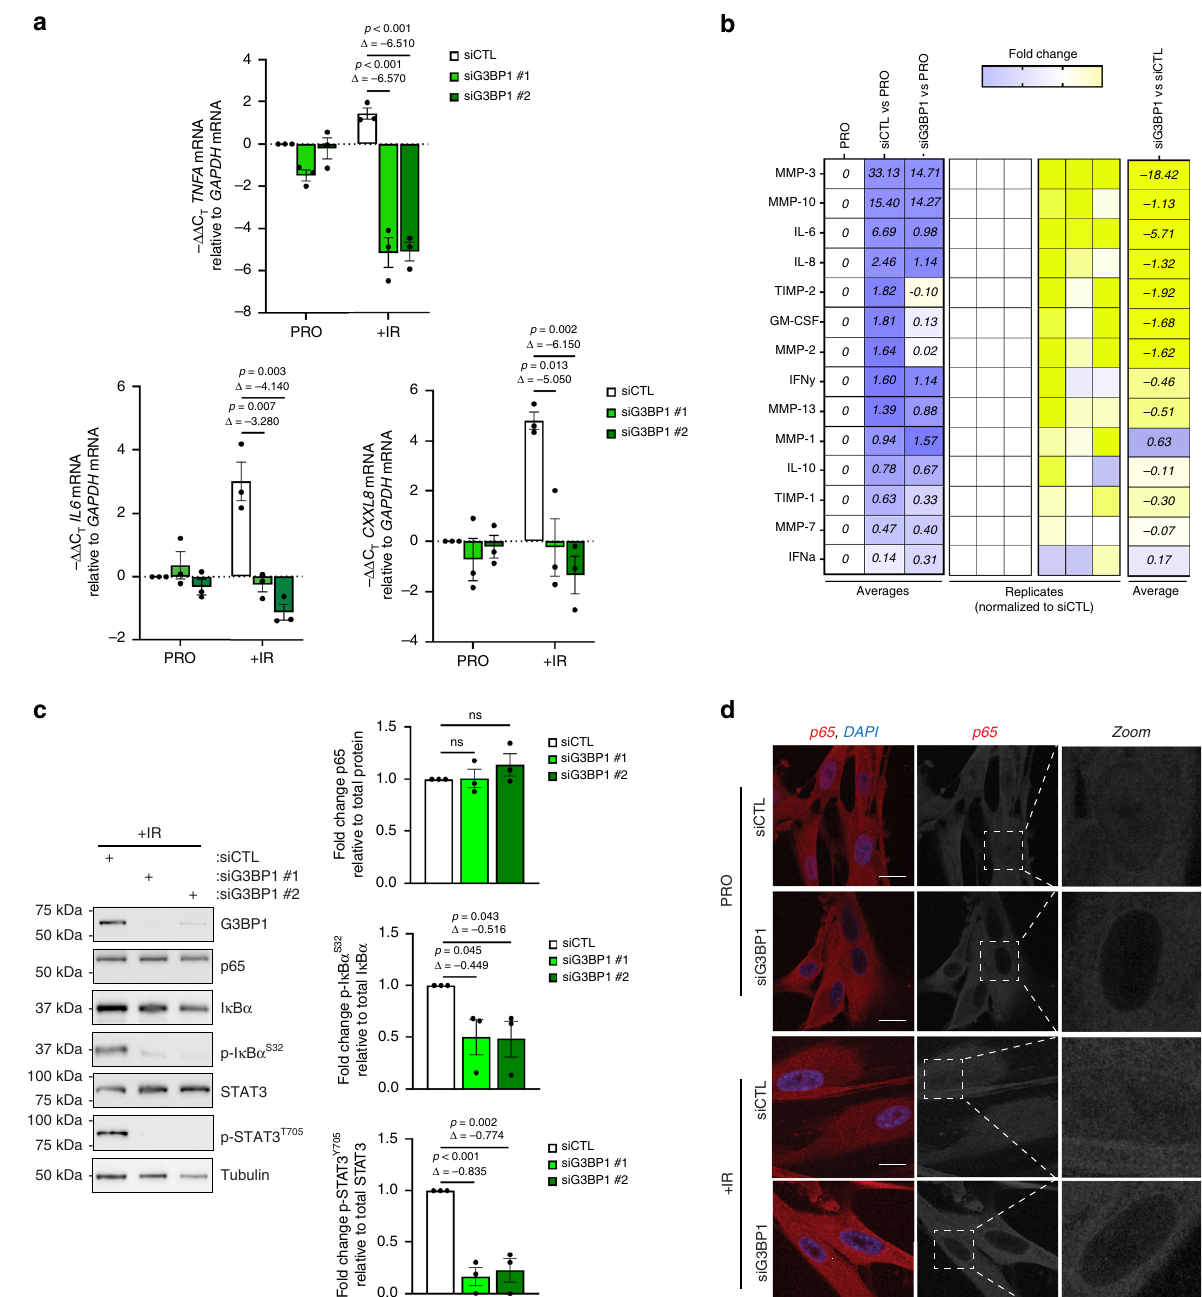
Fig. 3 Depletion of G3BP1 impairs canonical SASP signaling through reduction of STAT3 and NF- κ B signaling. WI-38 cells were treated with siRNA against G3BP1 (siG3BP1 #1 and #2) or scrambled control (siCTL) and assessed during proliferative stage (PRO) and 8-day post-ionizing radiation ( + IR). a RNA was extracted and assayed by RT-qPCR using primers against indicated mRNAs. The data are a mean of three independent experiments ± s.e.m (two-tailed unpaired Student ’ s t test, exact <0.001 p -values from left to right: 0.00095, 0.00022). b Conditioned media from PRO and from + IR WI-38 cells treated with siRNA against G3BP1 (siG3BP1) and scrambled control (siCTL) were analyzed by multiplex arrays. The heatmap indicates the fold change in comparison to the control PRO, SEN siCTL (siCTL), and SEN siG3BP1 (siG3BP1). Relative expression levels per replicate and average fold change differences are shown as indicated in heatmap. c (left) Cell lysates as described were subjected to western blot analysis against indicated proteins. (right) Quanti fi cations represent a mean of relative protein levels from three independent experiments ± s.e.m (two-tailed unpaired Student ’ s t test, exact <0.001 p -values from left to right: 0.0007). d WI-38 cells as described were analyzed by immuno fl uorescence with antibody against p65 during PRO and SEN. DAPI staining was used to visualize nuclei. Scale bar, 20 μ m. Source Data for panels ( a ) and ( c ) are provided in the Source Data File. Raw data for ( b ) is provided in Supplementary Data